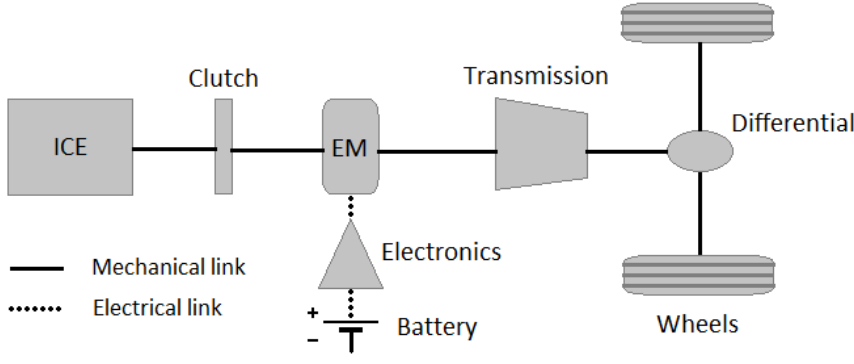
Figure 2. Schematic of the P2 drivetrain